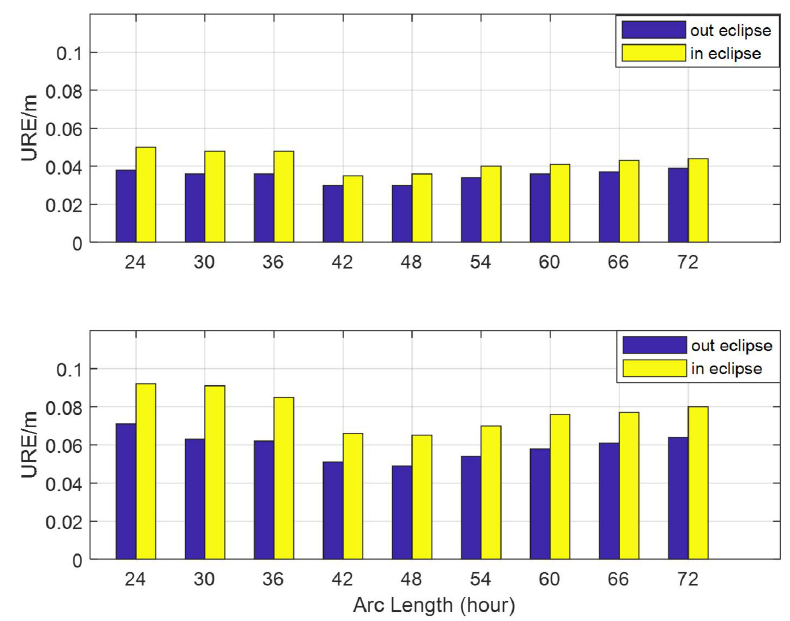
Figure 6. The URE of BDS-3 predicted orbits in and out of eclipse season with prediction intervals of 6 h ( top ) and 24 h ( bottom ).